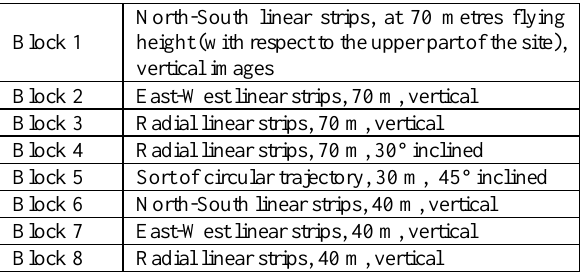
Table 2. List of the various blocks acquired Block 4 has the same strips as Block 3, but the camera axis was tilted at a 45° angle with respect to the nadir direction and the strips were all flown in only one direction, in order to always have the scarp in front of the camera; time interval and flying speed were kept constant.